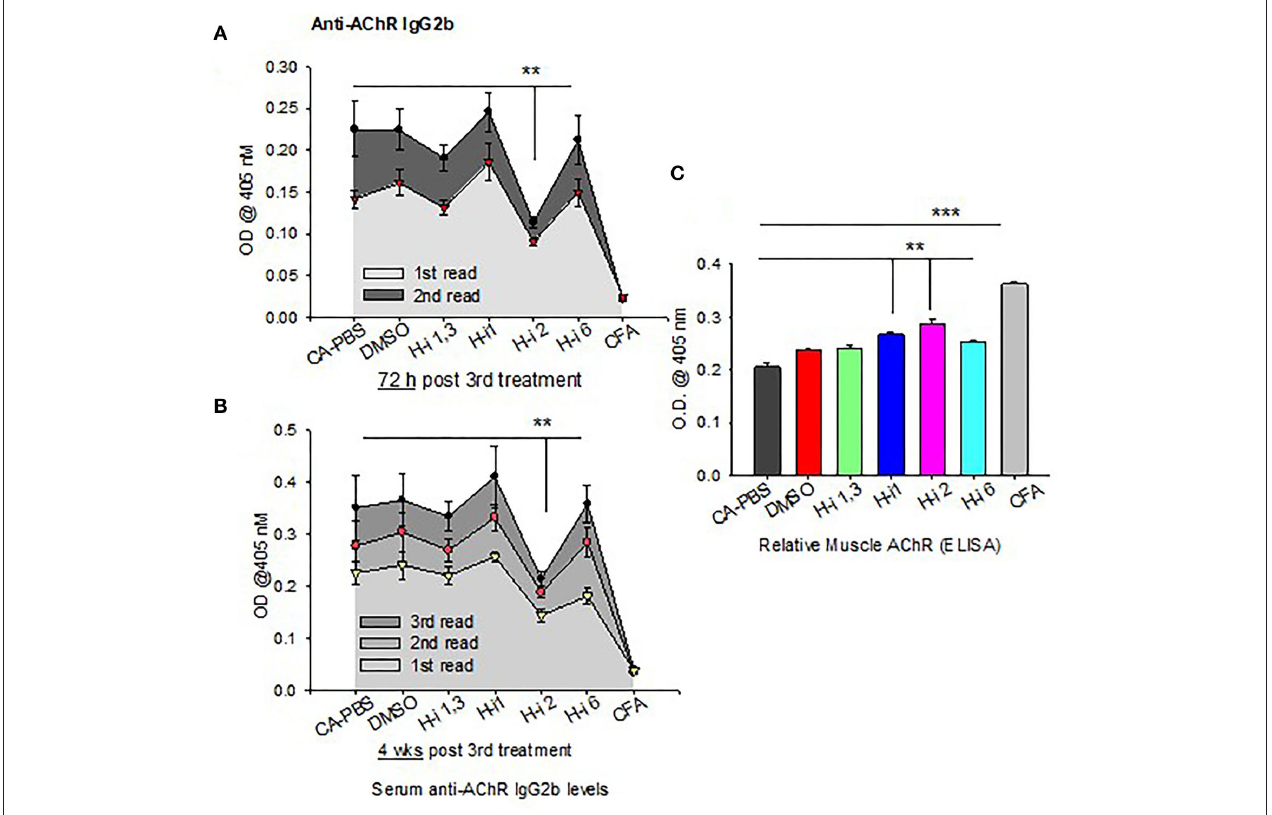
FIGURE 6 | AChR-specific IgG2b levels in EAMG mice ± HDAC-i. (A,B) CFA (untreated) and EAMG mice were treated with HDAC-i and their blood was collected to obtain the serum at 72h and 4 weeks post 3rd treatment. Serum dilutions were titrated to perform the ELISA for AChR-specific IgG2b ( n = 3 for the CFA group, n = 5 for each CA or EAMG group). Each plot shows multiple plate readouts at a minute or less interval using 405-nm OD. (C) Crude preparation of muscle receptor from forelimb muscle of CFA and EAMG mice were analyzed for relative density of functional AChR via ELISA (using absorbance at 405nm). ** P < 0.01, *** P < 0.001, One-way ANOVA. n = 3 for the CFA group, n = 5 for each CA-PBS, DMSO, and HDAC-i treated EAMG group. The experiment is representative of three similar experiments.